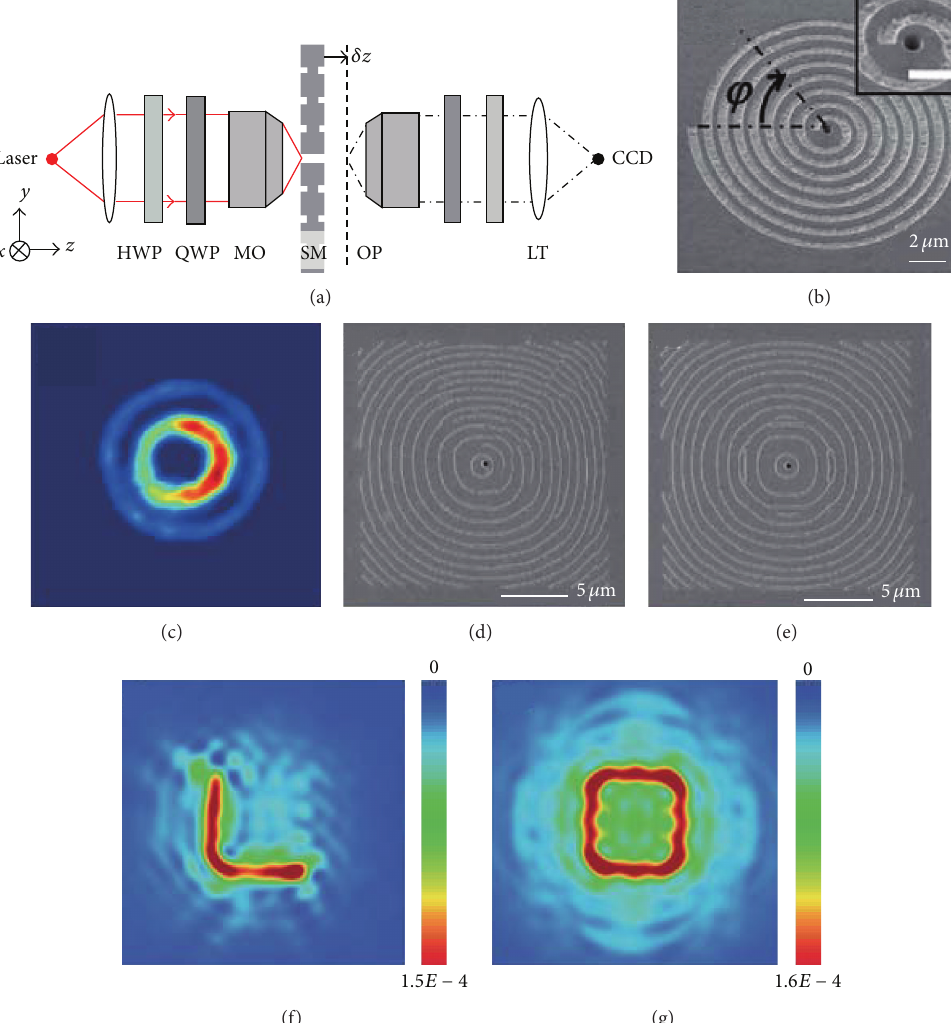
Figure 31: OAM generation and wavefront shaping by groove type SP-inspired metasurface. (a) Experimental setup of the OAM generation. (b) SEM image of the sample. (c) Intensity distribution imaged through the sample. (d, e) SEM images of the holographic metasurfaces. (f, g) Simulated images of the holographic images. Figures are reproduced from (a)–(c) [170] and (d)–(g) [171].